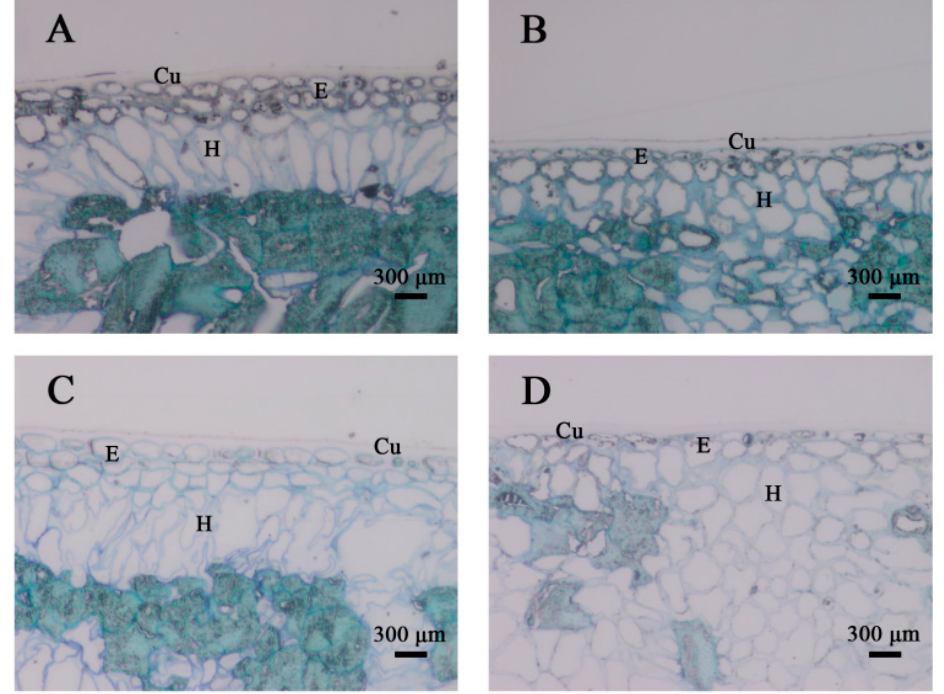
Figure 3. Structural changes occurring in fragments of cross-sections through the fruit peels of two persimmon cultivars during storage. ( A ) “Fupingjianshi”; ( B ) “Ganmaokui”; ( C ) “Fupingjianshi”; ( D ) “Ganmaokui”; ( A , B ) after harvest; ( C , D ) after 12 days of storage. Cu cuticle, E epidermis, H hypodermis.